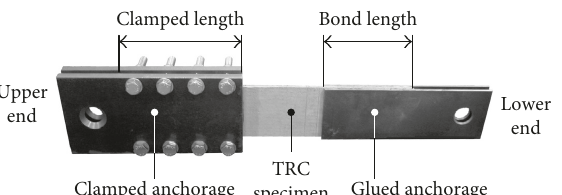
Figure 4: Specimen for adaptive testing of textile’s development length and anchorage devices.